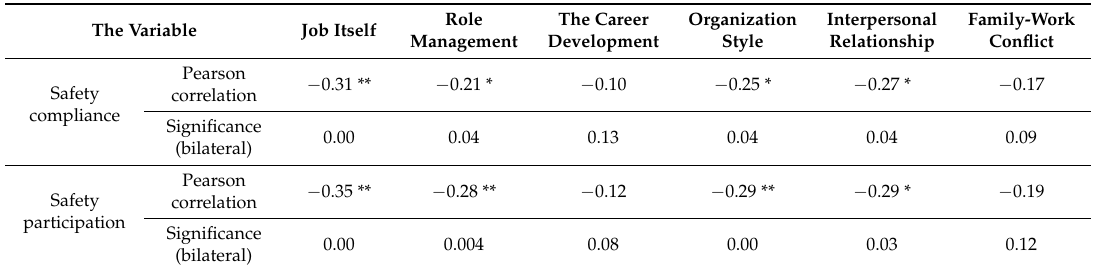
Table 7. Correlation analysis of each dimension ( n =